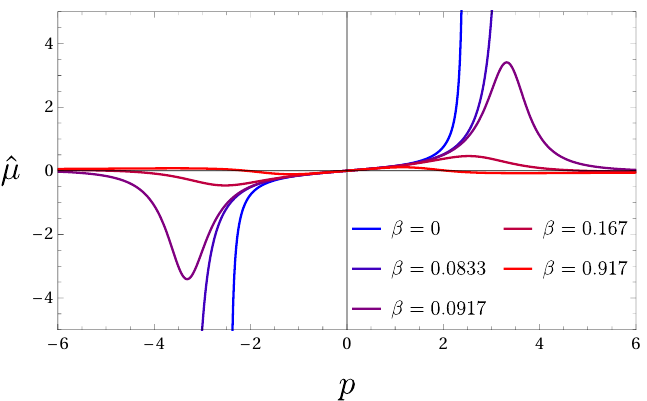
Figure 4. Dimensionless potential ˆ µ with respect to the parameter p for different values of the coupling β and α = 0 , in d = 4 dimensions. In this case, the condition for ˆ µ ( p ) to become 1 non-invertible is β > 1 / 12